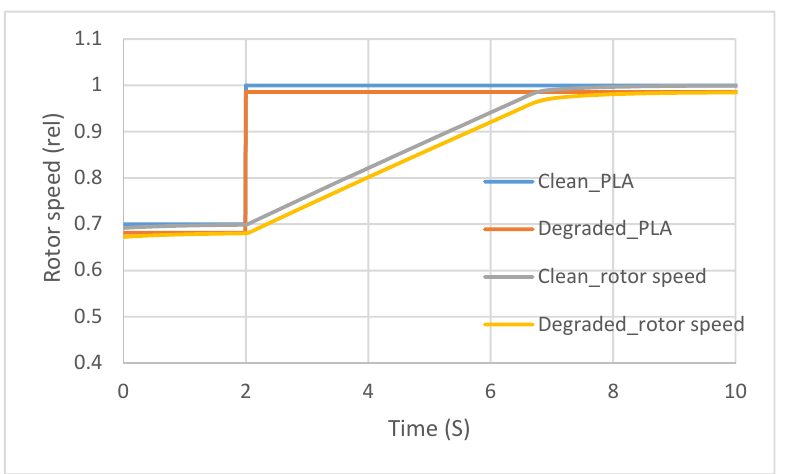
Figure 24. Comparison of the rotor speed of the clean engine with the clean controller and the degraded engine with the adjusted controller.